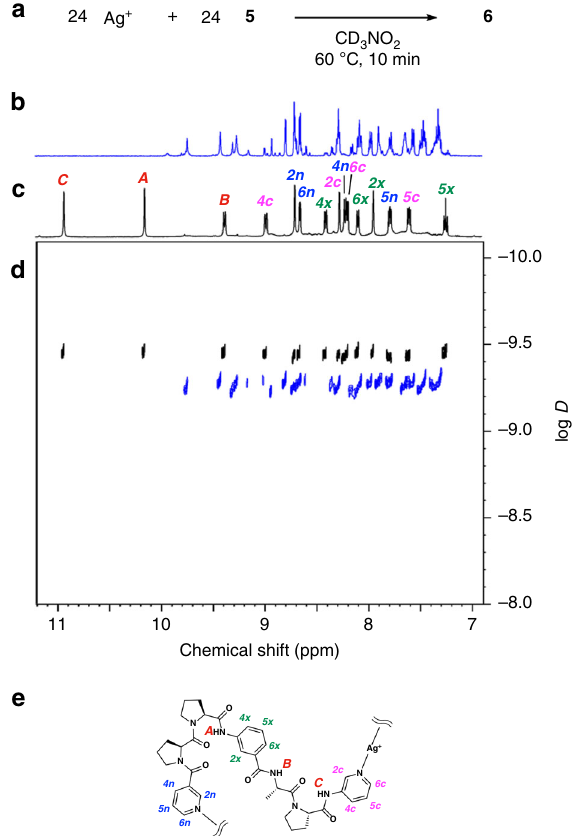
Fig. 3 1 H NMR and 1 H DOSY NMR spectra (500 MHz, 300 K) of peptide [6]catenane 6 and its building block 5. a Complexation scheme. b 1 H NMR spectrum of 5 in CD 3 NO 2 , and c that of 6 (Tf 2 N − salt). d Overlaid 1 H DOSY NMR spectra (aromatic region) of 5 (blue) and 6 (Tf 2 N − salt, black) in CD 3 NO 2 . e Proton labelling used for the signal assignment in